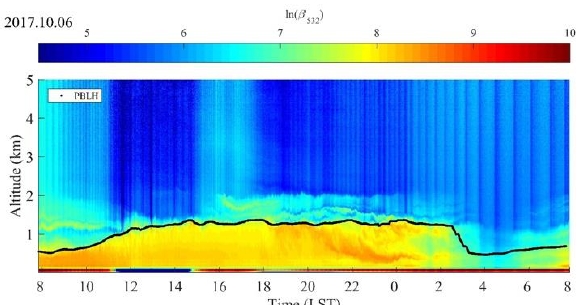
Figure 2. The aerosol layer height retrieved from wavelet covariance transform method in Beijing in Oct. 6, 2017. The lines connected by black dots in the figure represent the retrieved PBLH. The horizontal axis represents the local standard time (LST) and the vertical axis represents the height. Colorbar denotes the logarithm of the attenuated backscattering